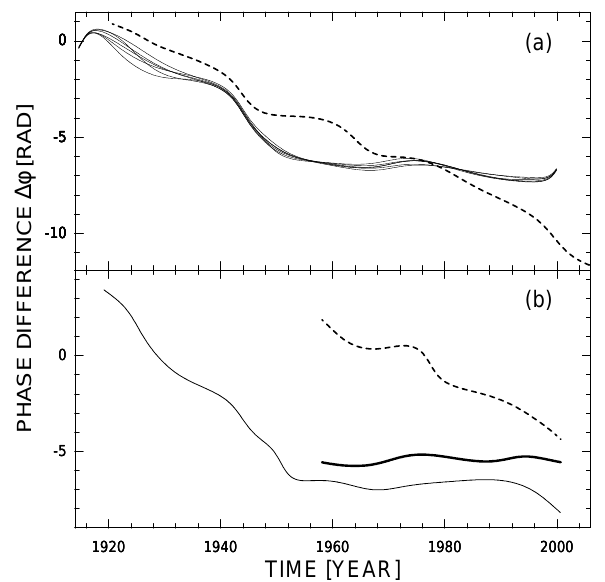
Fig. 1. The instantaneous phase differences of pairs of the oscilla- tory modes obtained using CCWT with the central wavelet period 96 months from (a) the aa index and the near-surface air temperature from the 6 European stations listed in the Data section (all except of Prague-Klementinum) (thin solid lines); the aa index and the 70 years shifted Prague-Klementinum near-surface air temperature series (dashed line); (b) the aa index and the Prague-Klementinum (14 ◦ 25’E, 50 ◦ 05’N) near-surface air temperature series (thin solid line); the aa index and the ERA40 near-surface air temperature clos- est to Prague grid point (15 ◦ 00’E, 50 ◦ 00’N) (thick solid line); and the aa index and the ERA40 near-surface air temperature from a no-coherence area (0 ◦ 00’E, 25 ◦ 00’N) (dashed line).